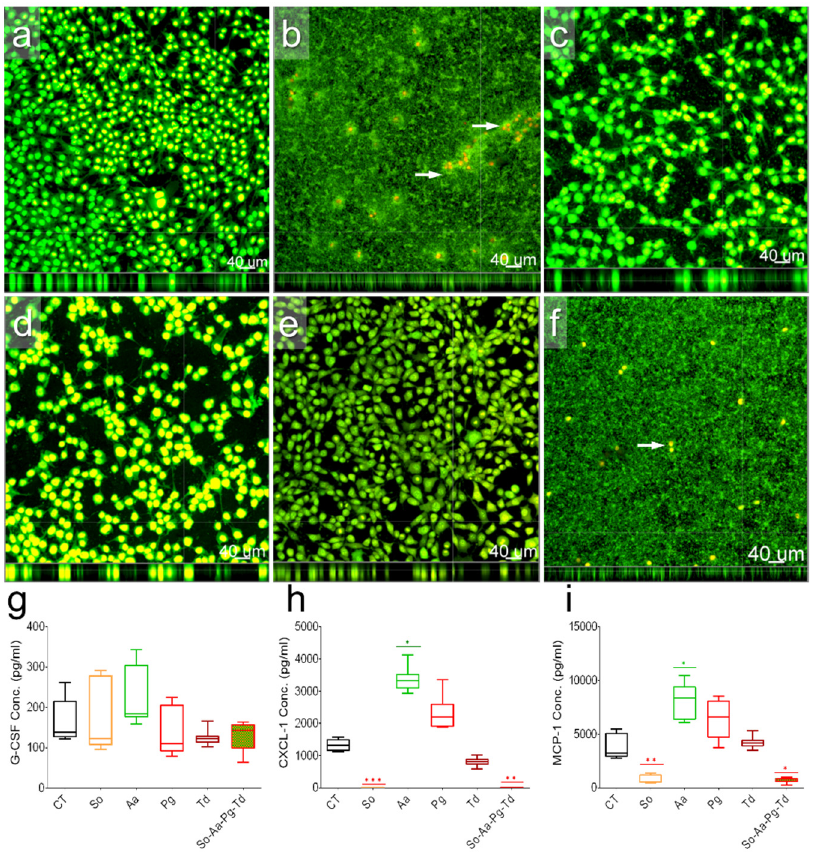
Figure 2. Morphology and the expression of G-CSF, CXCL-1, and MCP1 in fibroblasts. Microscopic documentation of unstimulated fibroblasts ( a ) as well as those stimulated with S. oralis surrounding murine fibroblasts ( b ), A. actinomycetemcomitans ( c ), P. gingivalis ( d ), and T. denticola ( e ), or a mixture of all four bacterial species ( f ). White arrows target remaining fibroblasts ( b , f ). The box and whisker graphs indicate the expression of G-CSF ( g ), CXCL-1 ( h ), and MCP-1 ( i ) in uninfected fibroblasts (CT) or after co-cultivation with S. oralis (So), A. actinomycetemcomitans (Aa), P. gingivalis (Pg), and T. denticola (Td), or a mixture of all species (So-Aa-Pg-Td). Significant changes according to the uninfected control were adjusted by Bonferroni correction for multiple tests. Symbols ***, **, and * indicate p < 0.001, p < 0.01, and p < 0.05, respectively.